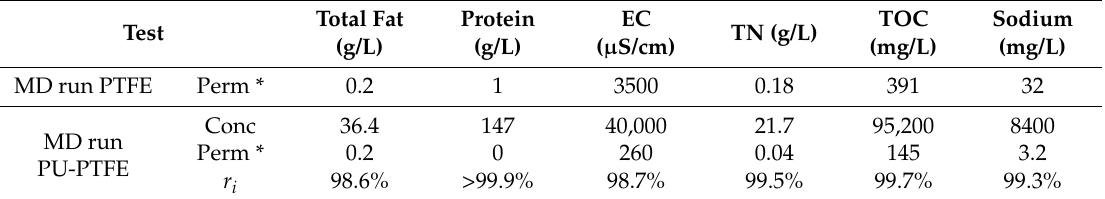
Table 4. PStW MD separation results of measured components using standard PTFE and PU-PTFE membranes. Original stick water properties shown in Table 1.